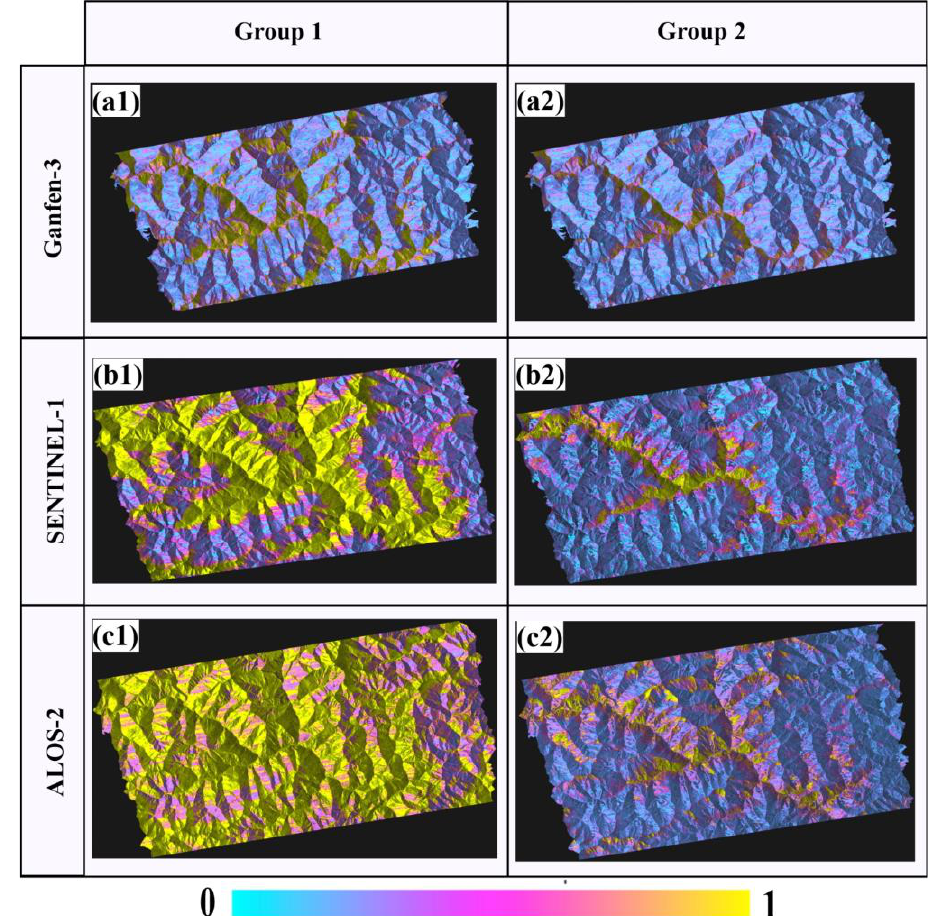
Figure 6. Comparison of coherence: ( a1 , a2 ) are the Gaofen-3 satellite ’s interference pairs from